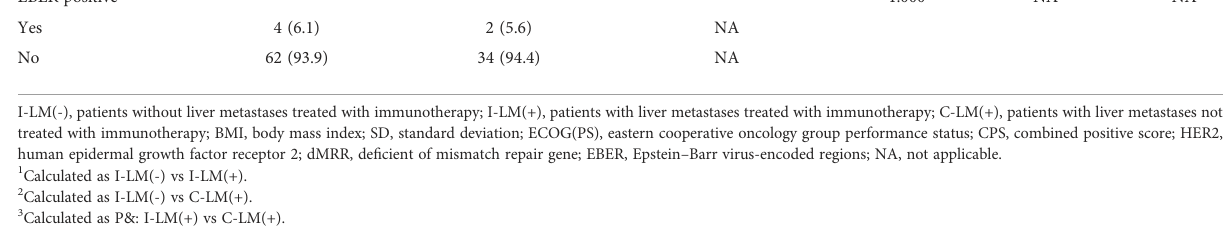
TABLE 2 Regime and best treatment response.